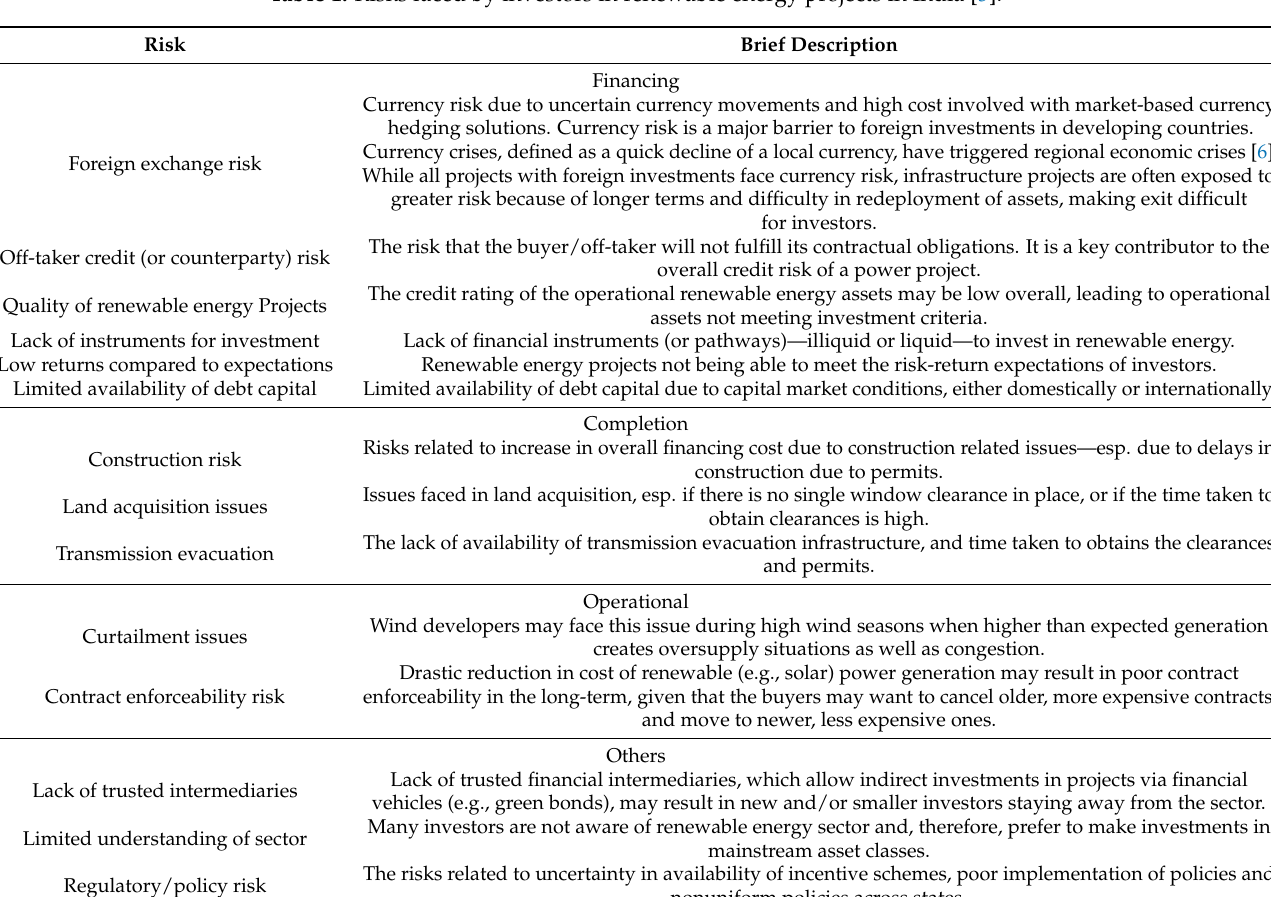
Table 1. Risks faced by investors in renewable energy projects in India